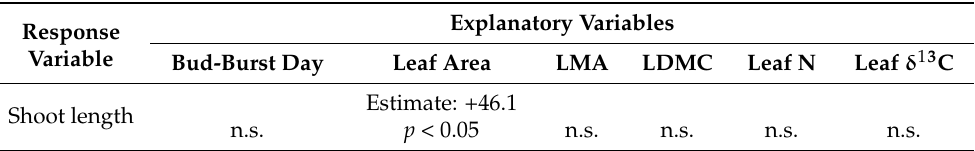
Figure 5. The leaf area of six tree species in June 2017 as influenced by the snowmelt treatment. The white boxes represent the data of the control (Con) and the blue boxes represent the snowmelt (SM) treatment. (n = 9). Ac = Acer mono , Be = Betula platyphylla , Co = Cornus controversa , Ka = Kalopanax septemlobus , Qu = Quercus crispula , and Ul = Ulmus davidiana. *: p < 0.05 by GLMM (for K. septemlobus , GLM analysis). Table 3. The best GLM selected to explain the shoot growth of K. septemlobus . n.s. = not significant. The estimated slope and p -value were judged with a Wald